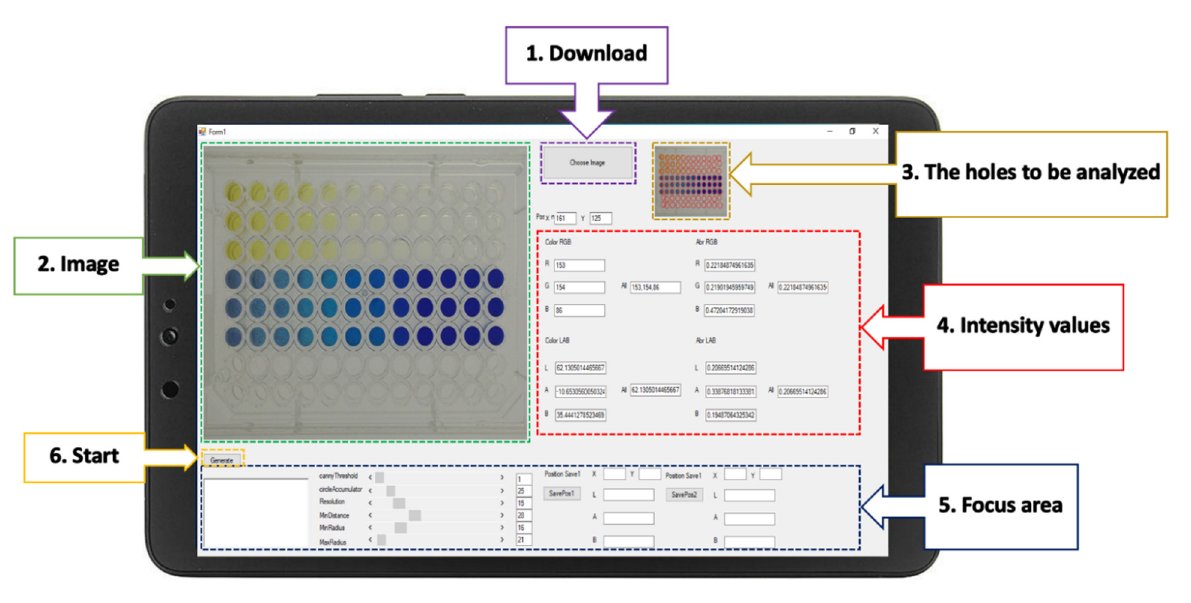
Figure 3. The graphical interface of the RGB analyzer program for the determination of multi ‐ explosives.